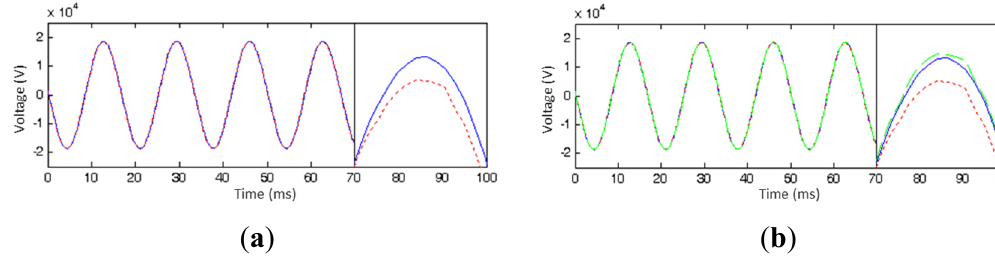
Figure 12. Results for 100% of the rated voltage: ( a ) v 1 (solid) and av 2 (dotted); and ( b ) v 1 (solid), av 2 (dotted), and v comp